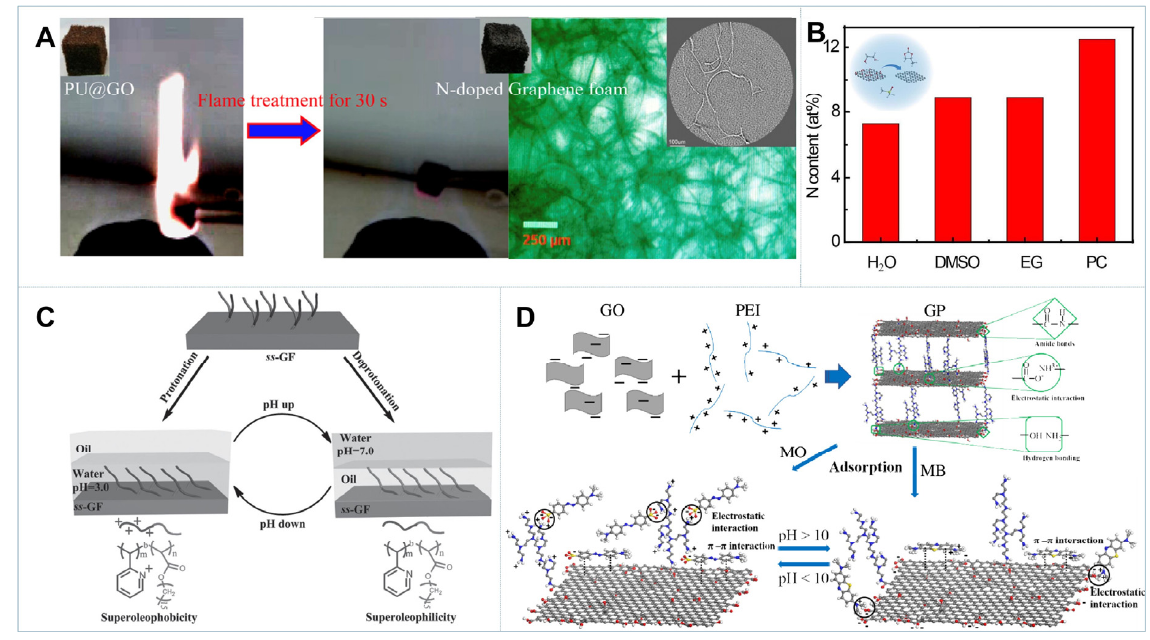
Figure 2. ( A ) Procedure for preparing N-doped graphene foam; [26] ( B ) N contents in the N-rGO organogels prepared in different solvents; [31] ( C ) Schematic illustration of switchable wettability of the as-synthesized ss-GF; [46] ( D ) Adsorption mechanisms of 3D GO/PEI aerogel with MB and MO under different pH values